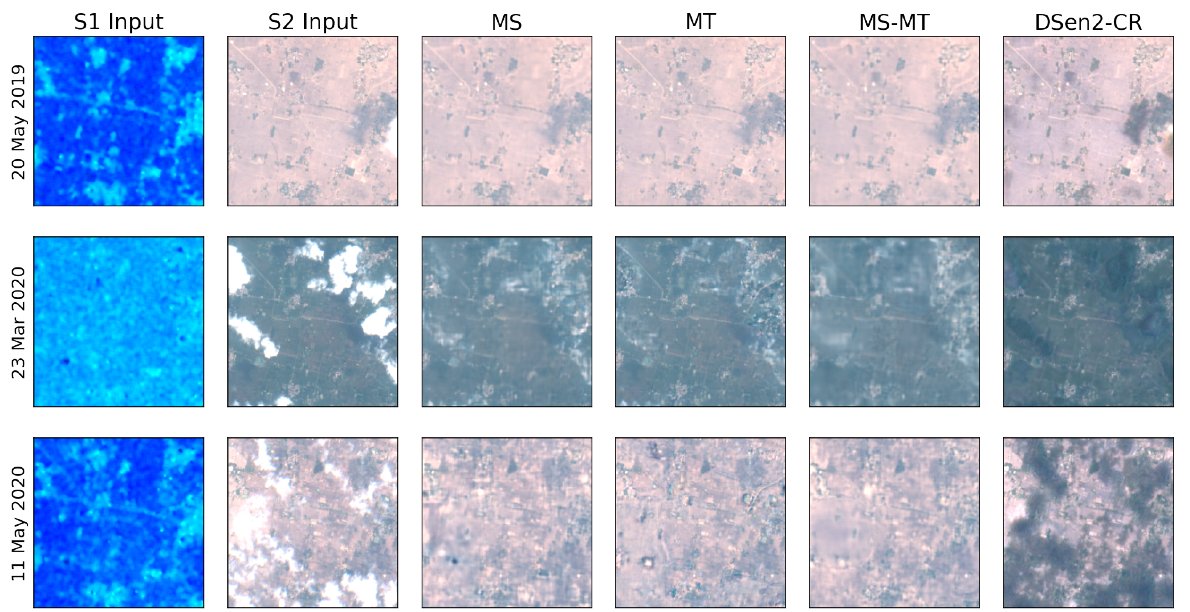
Figure 12. Results on the blind cloud removal task, with no available clear sky references for the India region. The cloud masks were annotated manually to enable the comparison with the DSen2-CR external